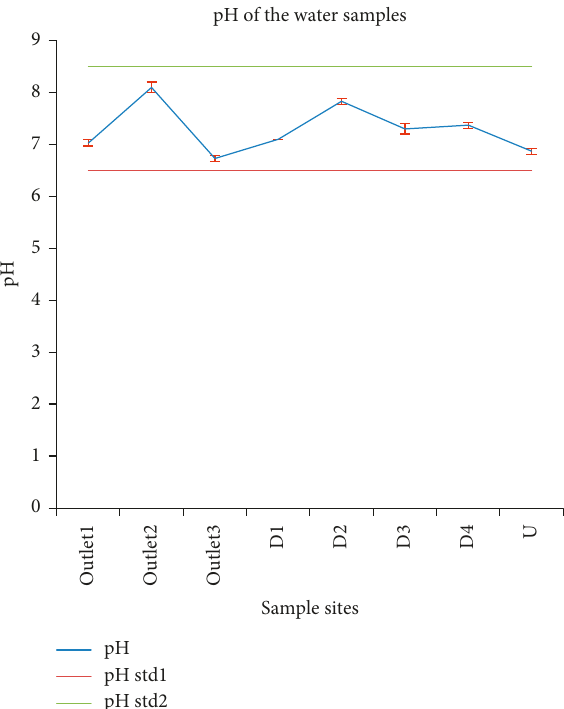
Figure 6: Comparison between pH values of the effluents of the study sites and the Ethiopian wastewater effluent discharge limit